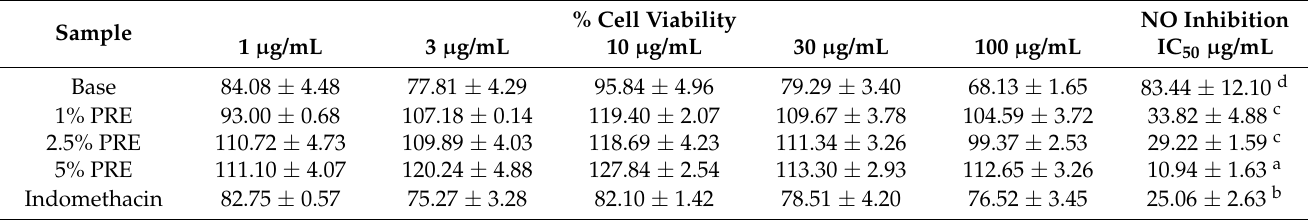
Table 11. Nitric oxide inhibitory activities of the microemulsion base and microemulsions containing PRE.